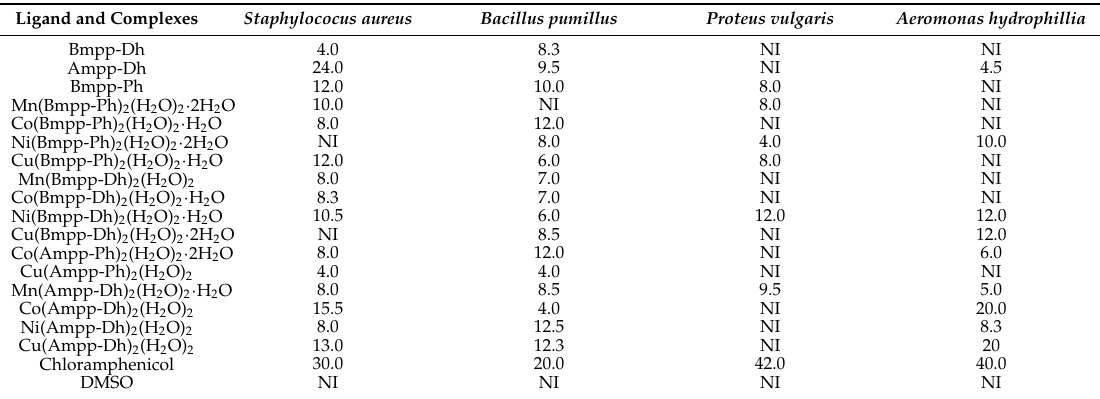
Table 2. Zone of growth inhibition exhibited by phenylhydrazone and metal complexes at 40 mg/mL (mm).